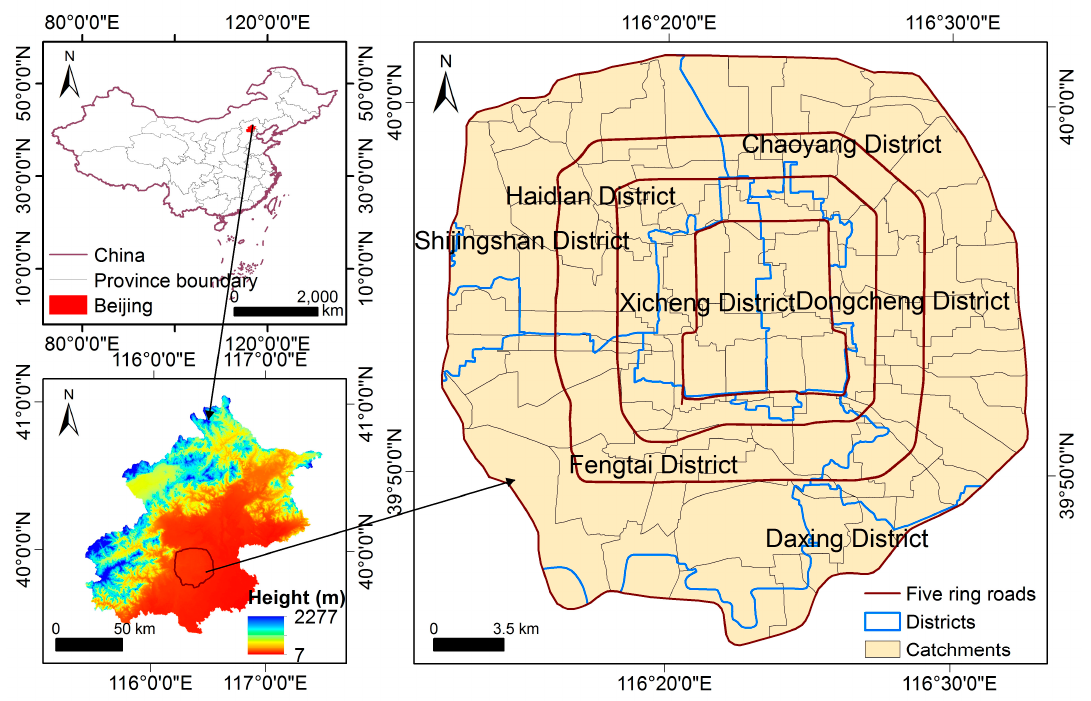
Figure 1. Location of the study area and the distribution of catchments in study area.